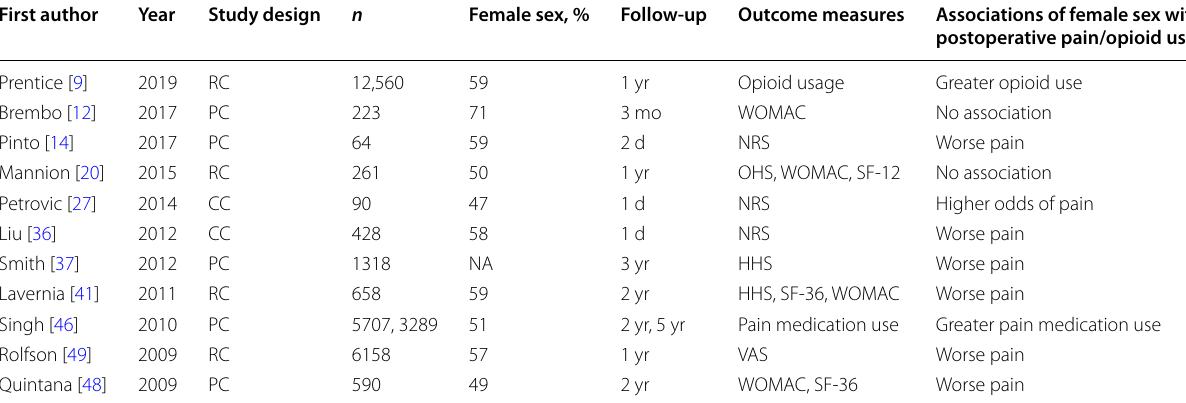
Table 5 Associations of female sex with pain/opioid use after